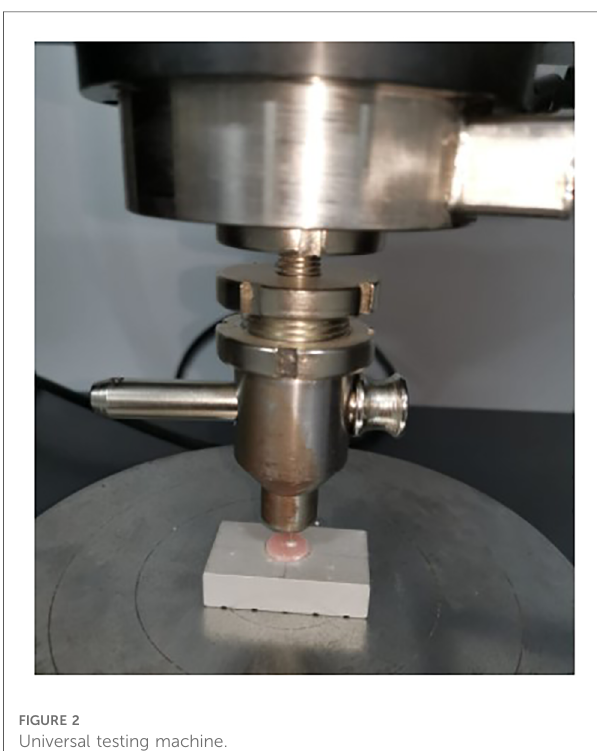
FIGURE 2 Universal testing machine.